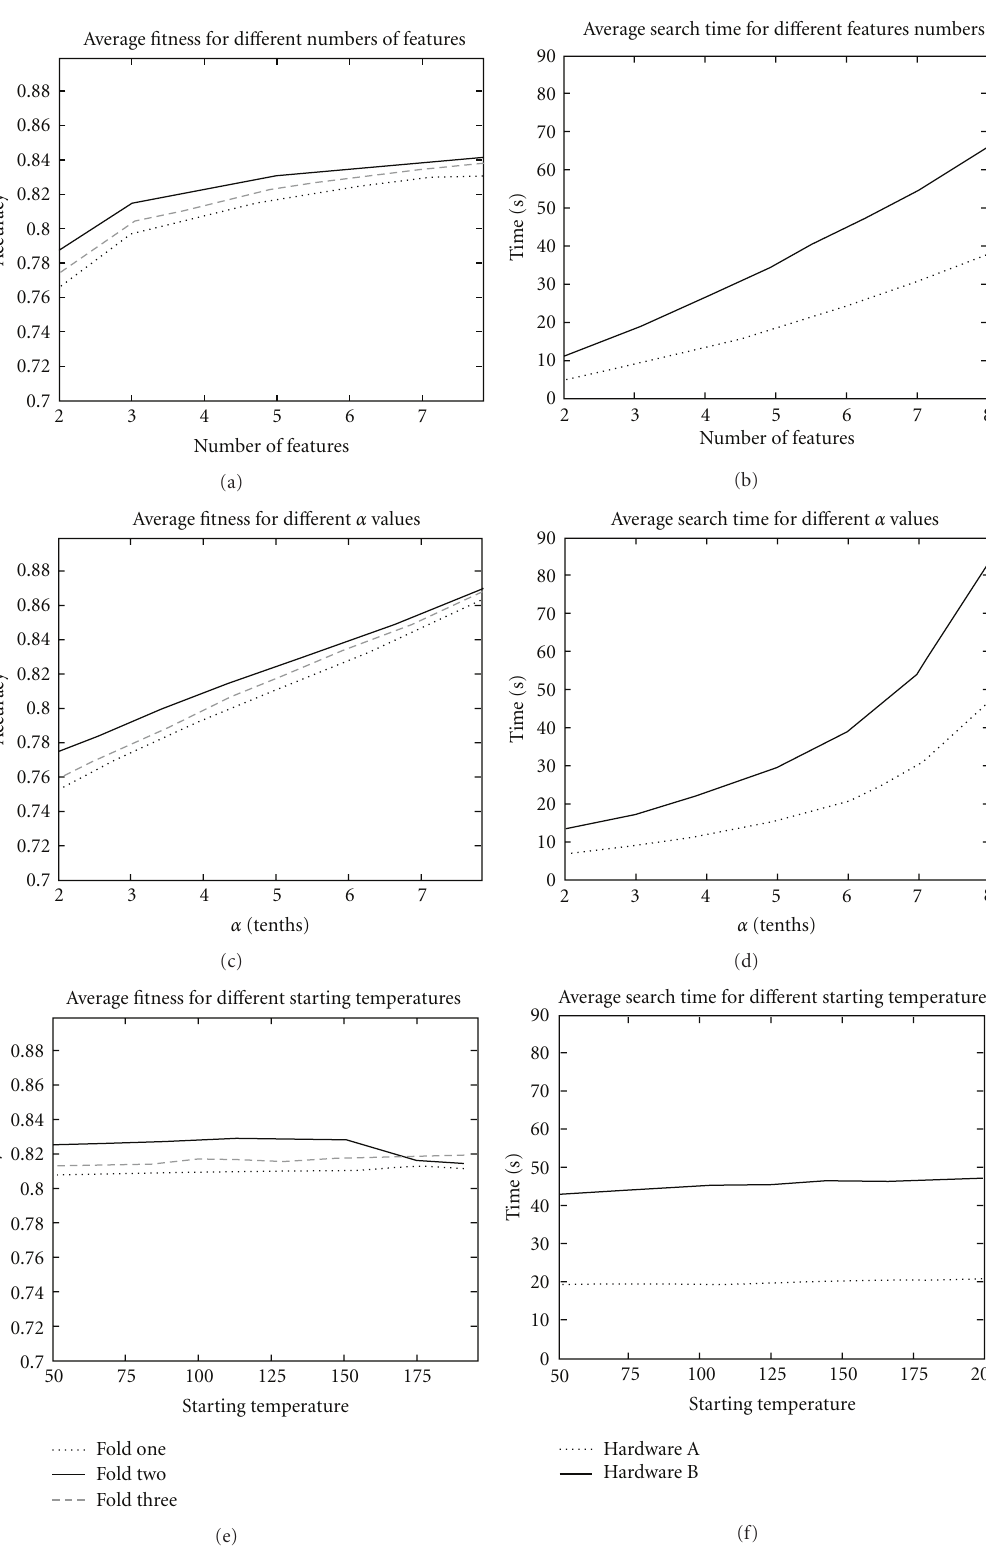
Figure 9: E ff ect of di ff erent parameter settings on overall classification accuracy and search time for Simulated Annealing on the Bos Wars data